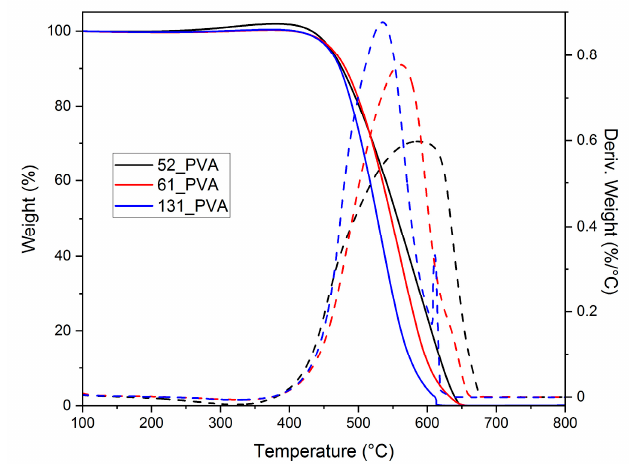
Figure 2. TG (solid) and DTG (dashed) curves recorded in flowing air for the carbon materials of various grain sizes synthesized by the carbonization of PVA-stabilized resole resins at 600 °C.